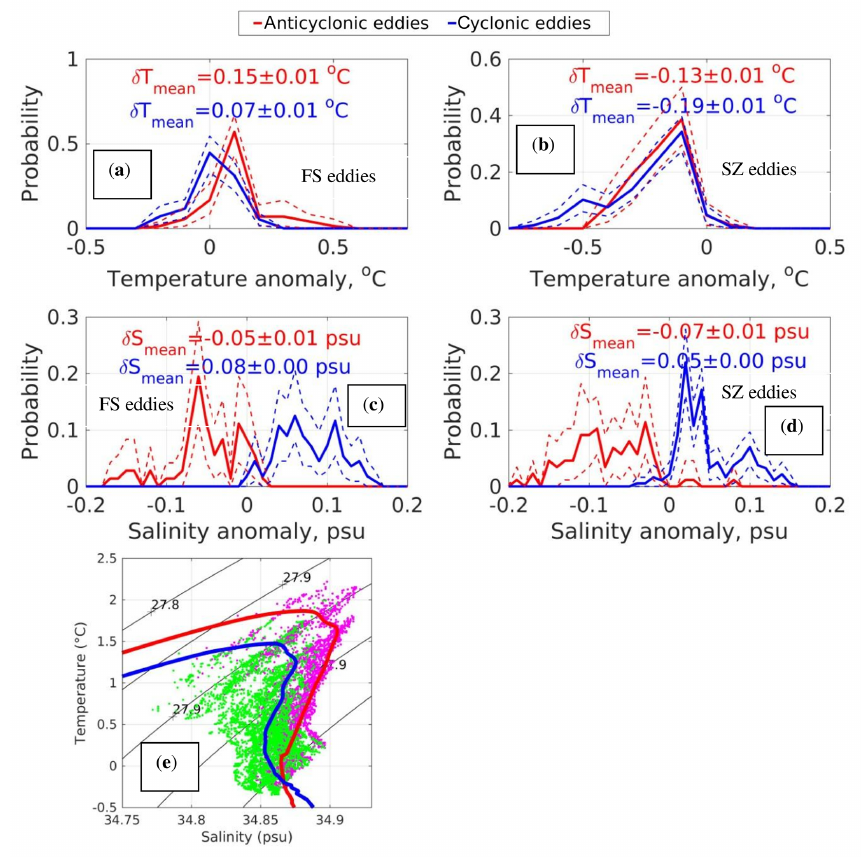
Figure 10. The probability distribution function of temperature (a, b) and salinity (c, d) anomalies inside cores of Fram Strait and Severnaya Zemlya eddies and the corresponding T – S plot (e) . Temperature and salinity anomalies were estimated for the layer above the Atlantic Water temperature core relative to the temperatures of ambient waters in the same layer. Dotted lines in panels (a–d) indicate the 95% confidence interval estimated by the bootstrap method. Magenta dots in (e) are used for FS eddies; green dots are used for SZ eddies. Red and blue solid lines show the T – S plot derived using climatological temperature and salinities averaged for the Fram Strait and Severnaya Zemlya areas. Black solid lines show